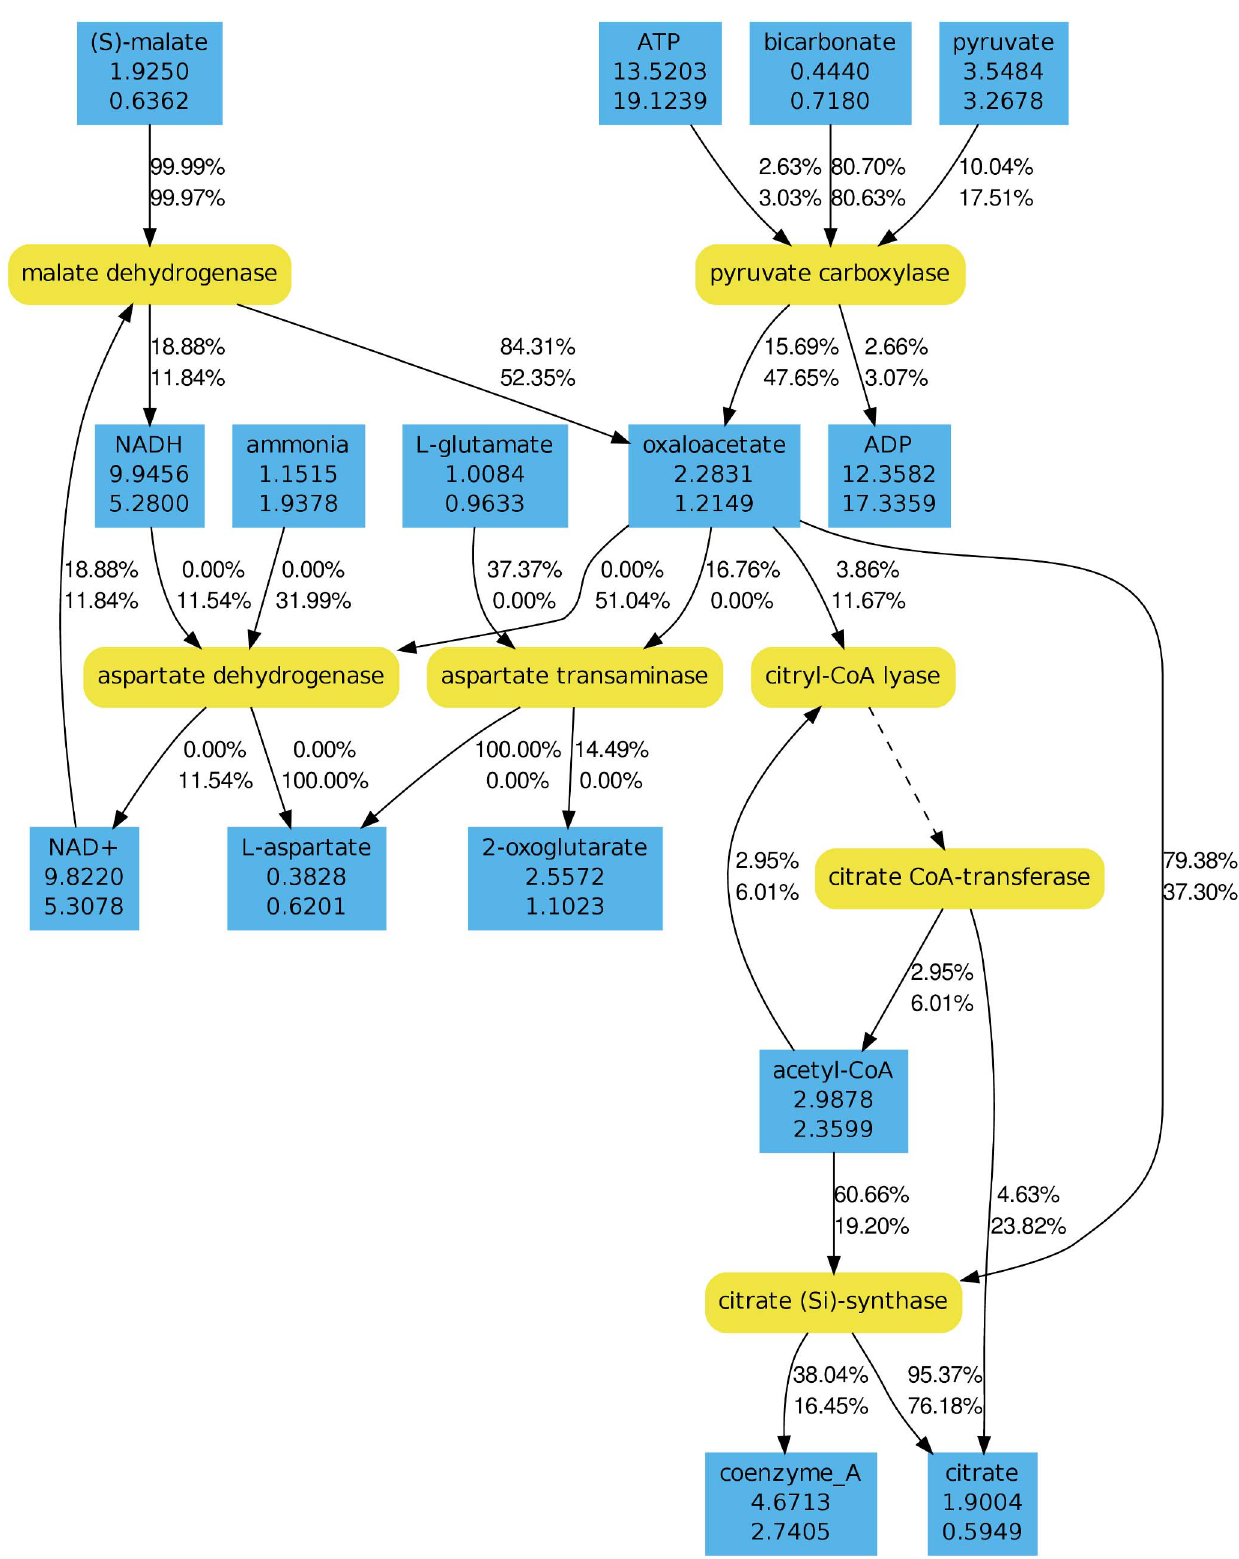
Figure 4. Metabolic context of oxaloacetate during growth on glucose. Reactions are shown in yellow (round boxes) while metabolites are shown in blue (angular boxes). The total flux through a metabolite is given in mmol/ ( g DW h ). Outgoing and incoming fluxes are given in percentages of the total flux. The upper numbers correspond to a dark states and the lower numbers to light states. In both cases growth on glucose was simulated under aerobic conditions.